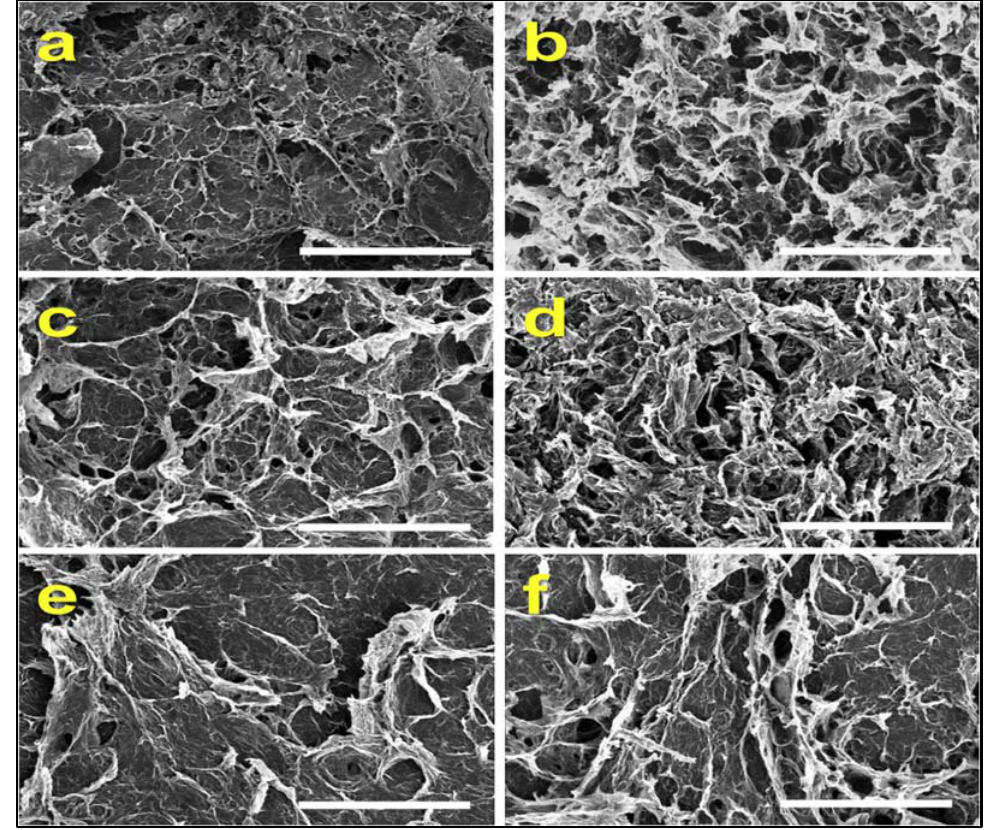
Figure 6. FE-SEM micrographs of ( a ) GNS, ( b ) B-GNS-0.2, ( c ) B-GNS-0.4, ( d ) B-GNS-0.6, ( e ) B-GNS-0.8, and ( f ) B-GNS-1.0. The scale bars represent 5 mm. Adapted from Chowdhury et al. [49], with permission from Elsevier. Copyright (2018).